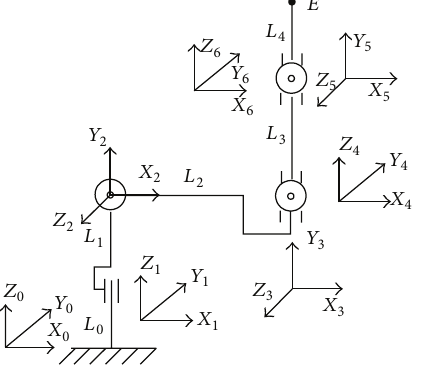
Figure 9: 3D manipulator